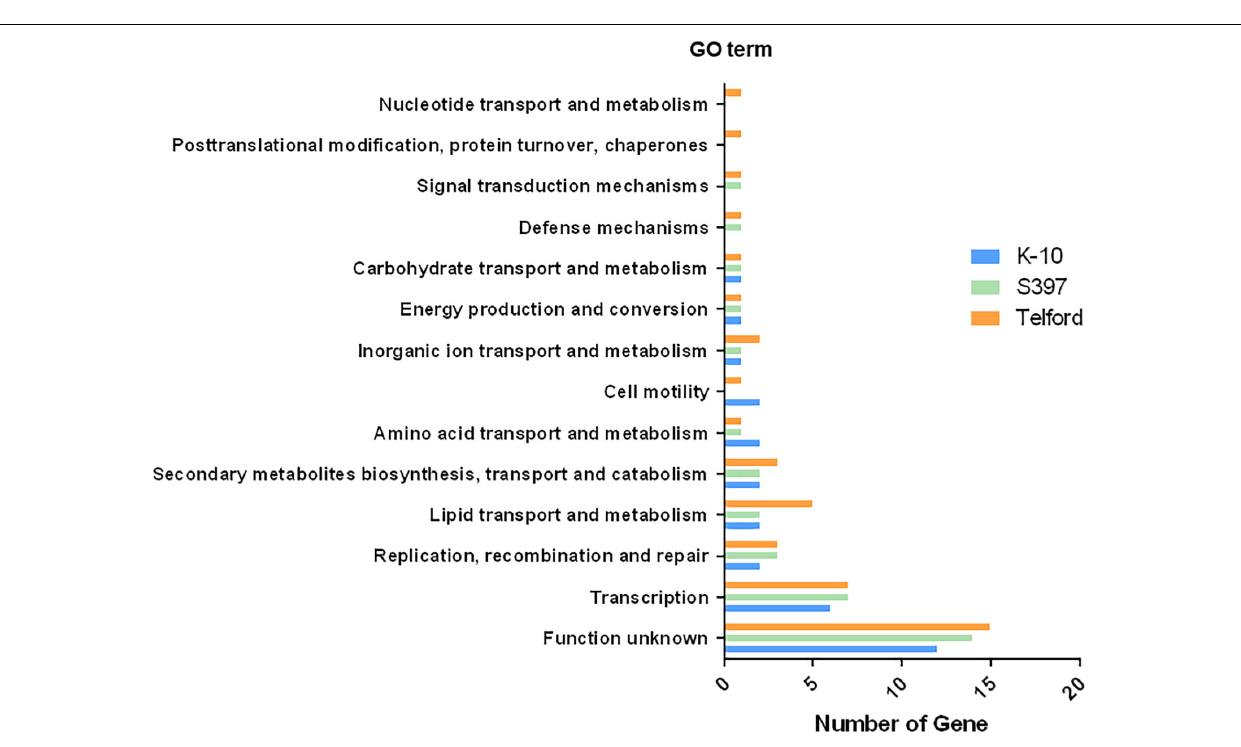
FIGURE 7 | IS 900 sites associated with functional genes and pathways. The diagram indicates Gene Ontology (GO) enrichment analysis of predicted coding sequences near IS 900